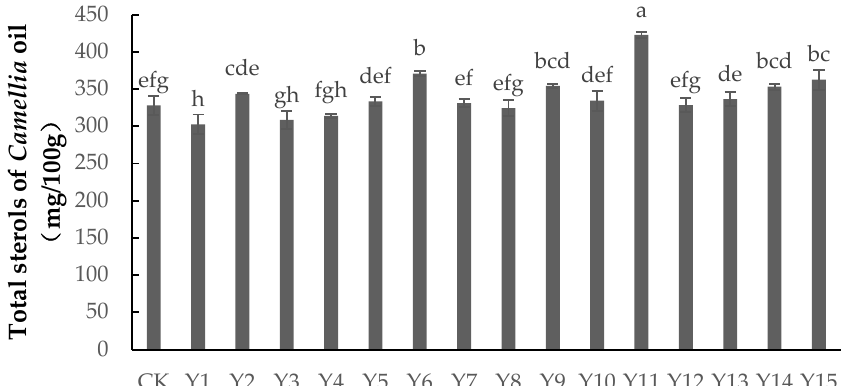
Figure 1. The content of total sterols in Camellia oil under different treatments. Note: Data indicate mean ± SE ( n = 3). Different letters indicate significant differences ( p < 0.05) between different